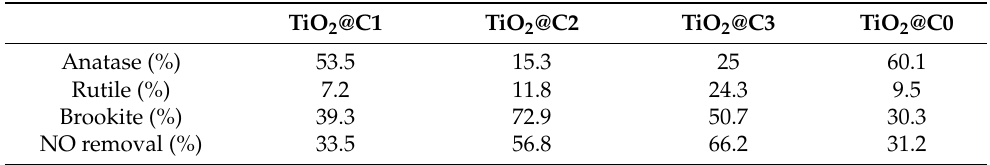
Figure 5. XRD spectra of TiO 2 @C1, TiO 2 @C2, TiO 2 @C3, and TiO 2 @C0. Table 3. Relative composition of crystalline phases and NO removal (%) of TiO 2 @C1, TiO 2 @C2, TiO 2 @C3, and TiO 2